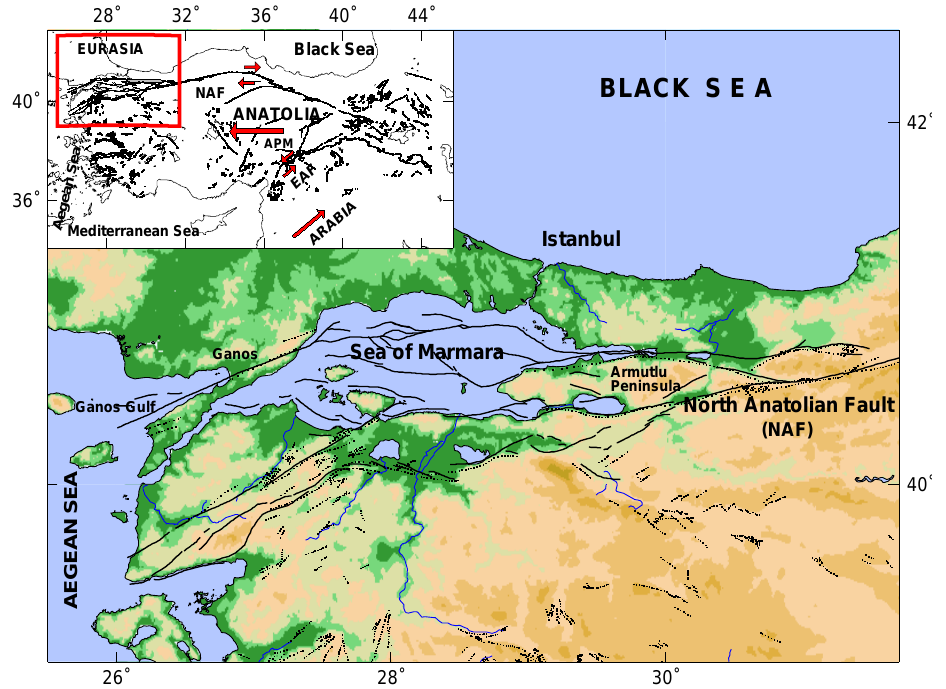
Fig. 1. Tectonic map of Marmara region (dot black faults from Saroglu et al., 1987, thick black faults from Armijo et al., 1999). Inset: The location of the study area within Turkey is marked